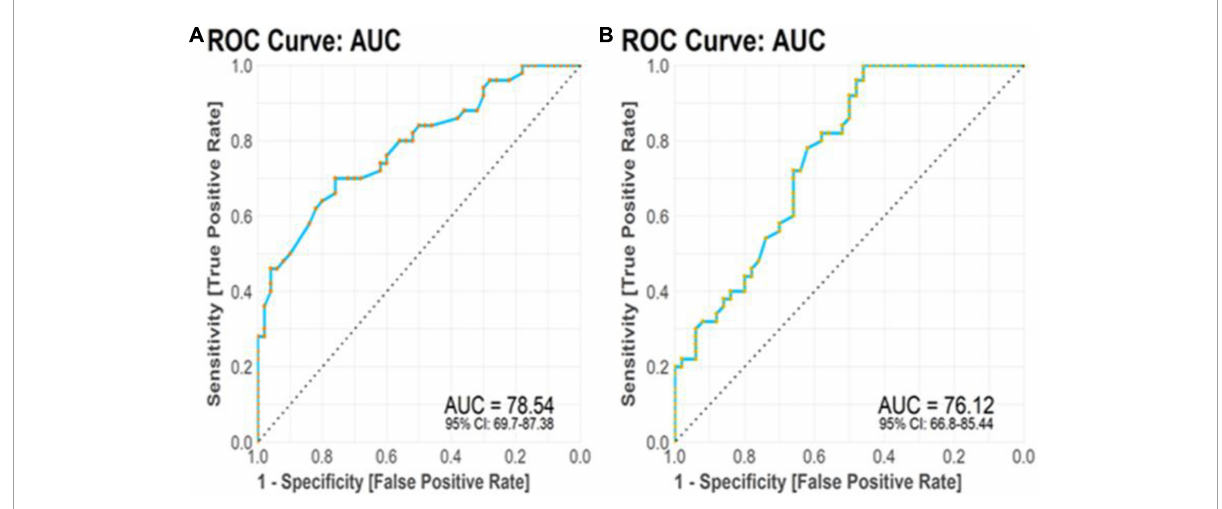
FIGURE7 Receiver operating characteristic (ROC) curve analysis. (A) TTP transcript levels displayed diagnostic power of 0.7854. (B) BDNF transcript levels displayed diagnostic power of 0.7612.